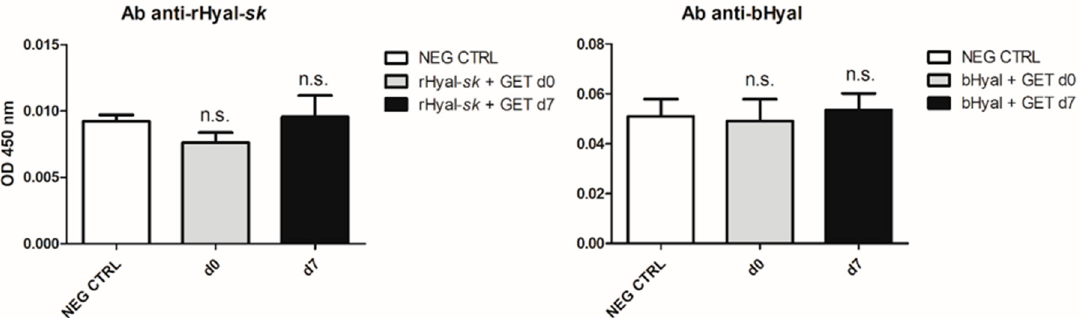
Figure 4. Anti-rHyal- sk antibody production. ELISA was performed with mouse sera (1:100 dilution) harvested 3 h (d0) (n = 4) and 7 days (d7) (n = 4) after Hyal injection in the presence of GET. No significant difference was observed between OD 450 nm of rHyal- sk + GET treated muscle d7 versus NEG CTRL, p = 0.84 (n.s.), equally between bHyal + GET treated muscle d7 versus NEG CTRL, p = 0.79 (n.s.). NEG CTRL, negative control (untreated muscle); rHyal- sk , recombinant Hyal, Fidia Farmaceutici; bHyal, bovine Hyal, Sigma-Aldrich; n.s., not significant. Statistical analysis: unpaired Student’s t test. Data are Mean ± SD.